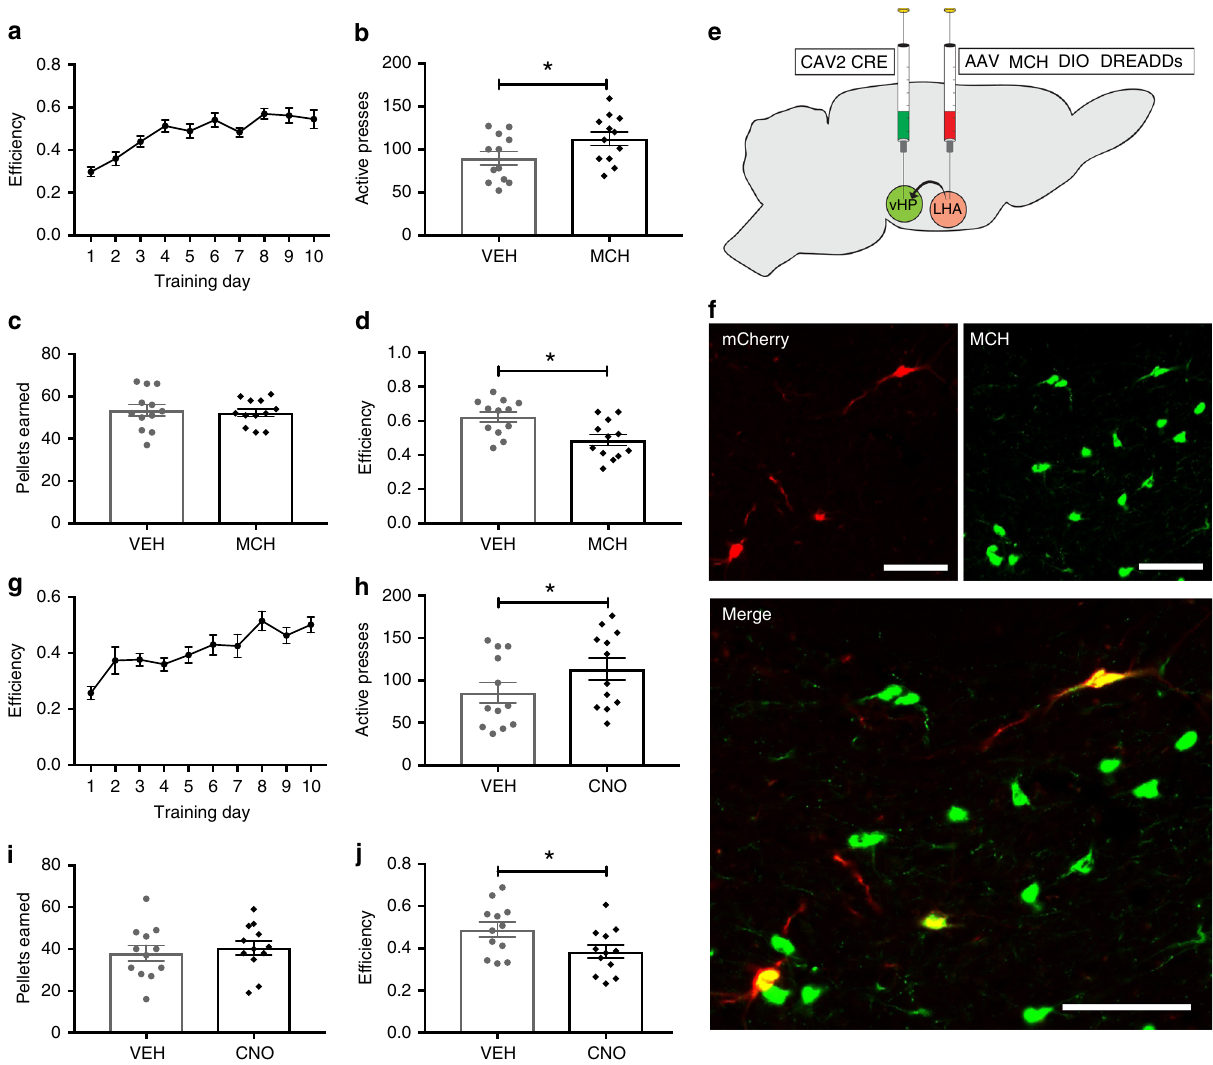
Fig. 3 Activation of MCH-vHP signaling increases food impulsivity. a – d Effects of vHP injection of MCH on impulsive responding for food in the DRL task: a ef fi ciency data during the training phase in DRL 20. ( b – d ; data were analyzed using Student ’ s two-tailed, paired t tests; n = 12). b Number of active lever presses during test phase ( P = 0.02). c Number of pellets earned during test phase. d Ef fi ciency in the DRL test phase ( P = 0.008). e Schematic cartoon depicting methods for dual virus chemogenetic approach. The retroactively transported canine adenovirus 2 (CAV2 CRE) was used to deliver the transgene for cre recombinase to vHP projection neurons following direct injection into the vHP. A cre-dependent adeno-associated virus containing excitatory MCH DREADDs – mCherry transgene (AAV2 MCH DIO DREADDs) was injected into the LHA and ZI. f Representative images of fl uorescent reporter localization in MCH neurons. g – j Effects of chemogenetic activation of MCH neurons that project to the vHP on impulsive responding for food in the DRL test session: g ef fi ciency data during the training phase in DRL 20. ( h – j ; data were analyzed using Student ’ s two-tailed, paired t tests; n = 12), h number of active lever presses during DRL testing ( P = 0.03), i number of pellets earned during DRL testing, and j ef fi ciency during the DRL testing ( P = 0.03). Data shown